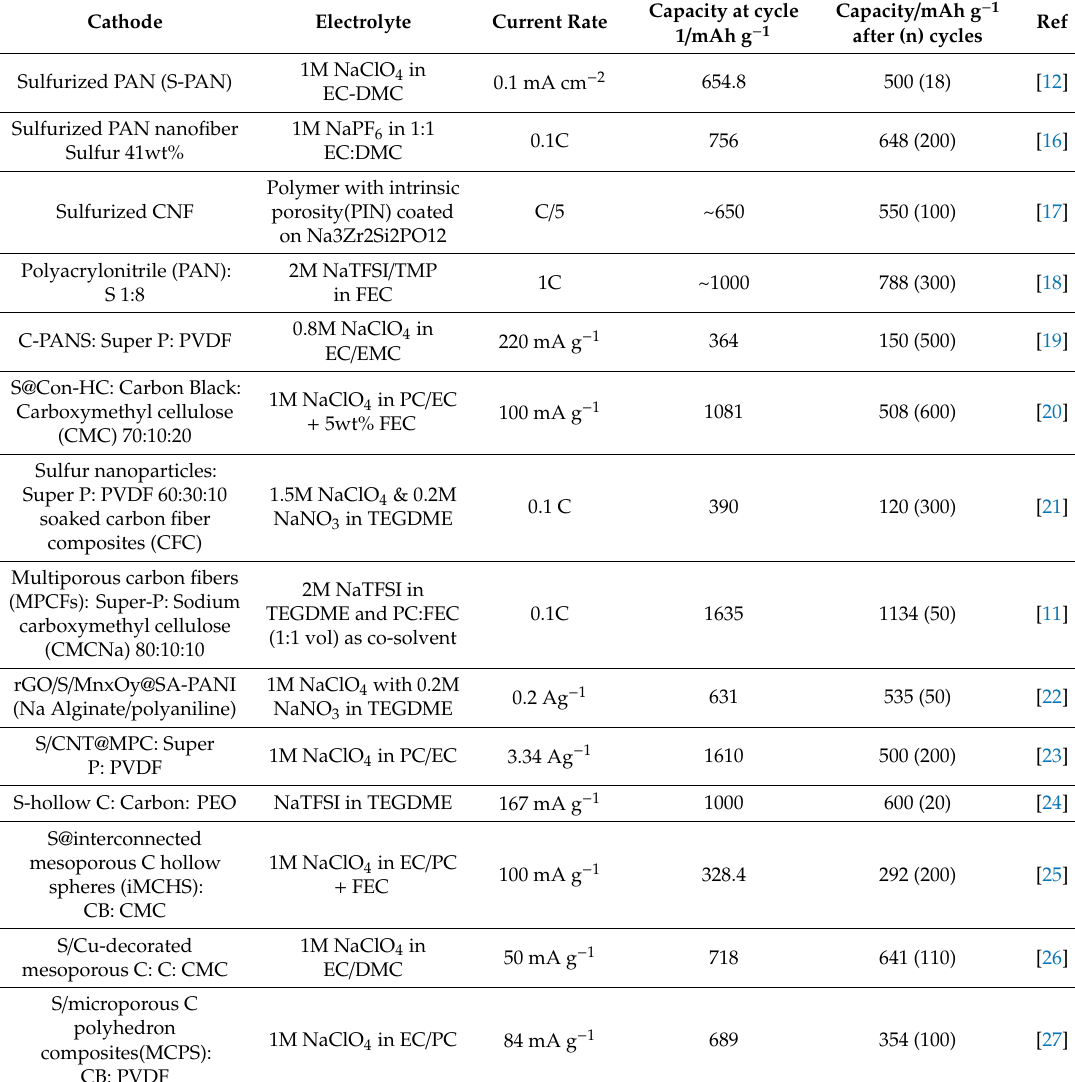
Table 1. Literature review of components and performance of various Na-sulfur batteries. Cathode Electrolyte Sulfurized PAN